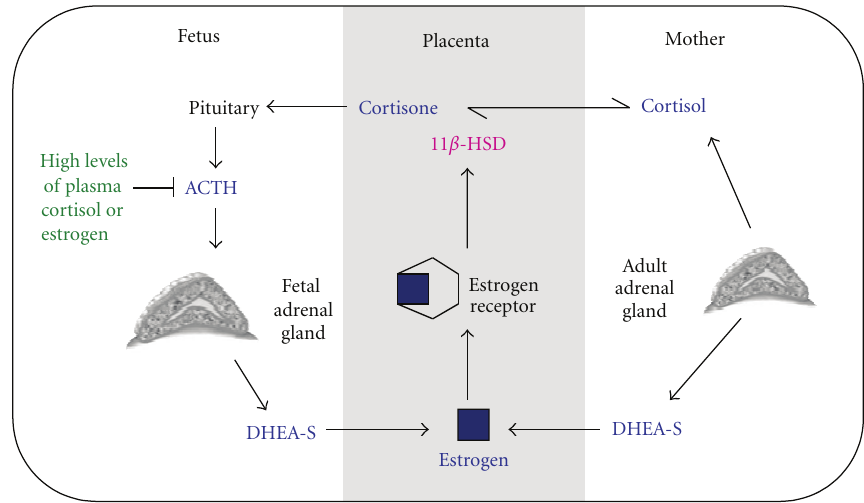
Figure 3: Representation of how placental estrogen during gestation modulates its own production. Placental estrogen has a positive and a negative feedback mechanism to ensure that physiological levels of estrogen are established. Estrogen produced by the placenta induces a positive feedback mechanism by promoting the conversion of cortisol to its biologically inactive metabolite cortisone through upregulation of 11 β -HSD expression. Serum cortisone levels stimulate the fetal pituitary gland to produce ACTH which upregulates DHEA-S production from the fetal adrenal cortical zone and leads to placental estrogen production. In contrast, if placental estrogen concentrations are too high, placental estrogen can inhibit its own production by suppressing the responsiveness of the fetal adrenal zone to ACTH and lowering its production of DHEA-S. This figure has been modified from Albrecht et al.